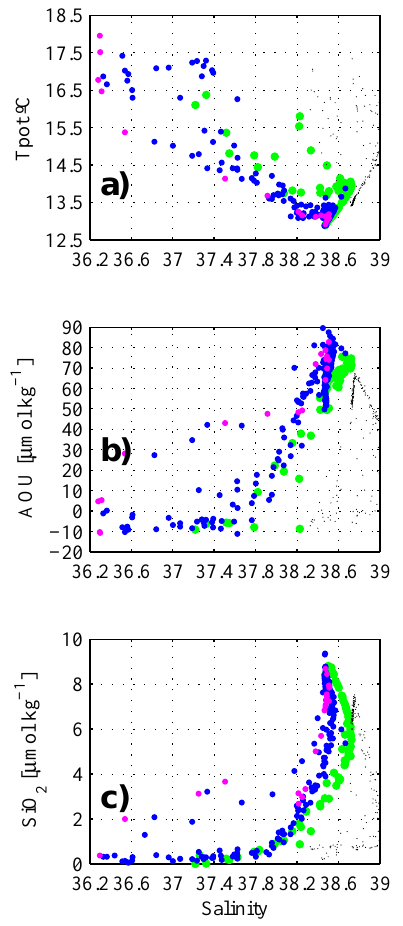
Fig. 13. Property-property plots for the M84/3 data in the western basin: Tyrrhenian Sea (green dots), Western basin (blue) and Strait of Gibraltar (magenta). Light black dots correspond to Ionian Sea data. (a) Potential temperature ( ◦ C) vs. salinity, (b) Apparent Oxygen Utilization (AOU in µmolkg − 1 ) vs. salinity and (c) silicate con- centration (SiO 2 in µmolkg − 1 ) vs. salinity. The station positions are shown in Fig. 1.